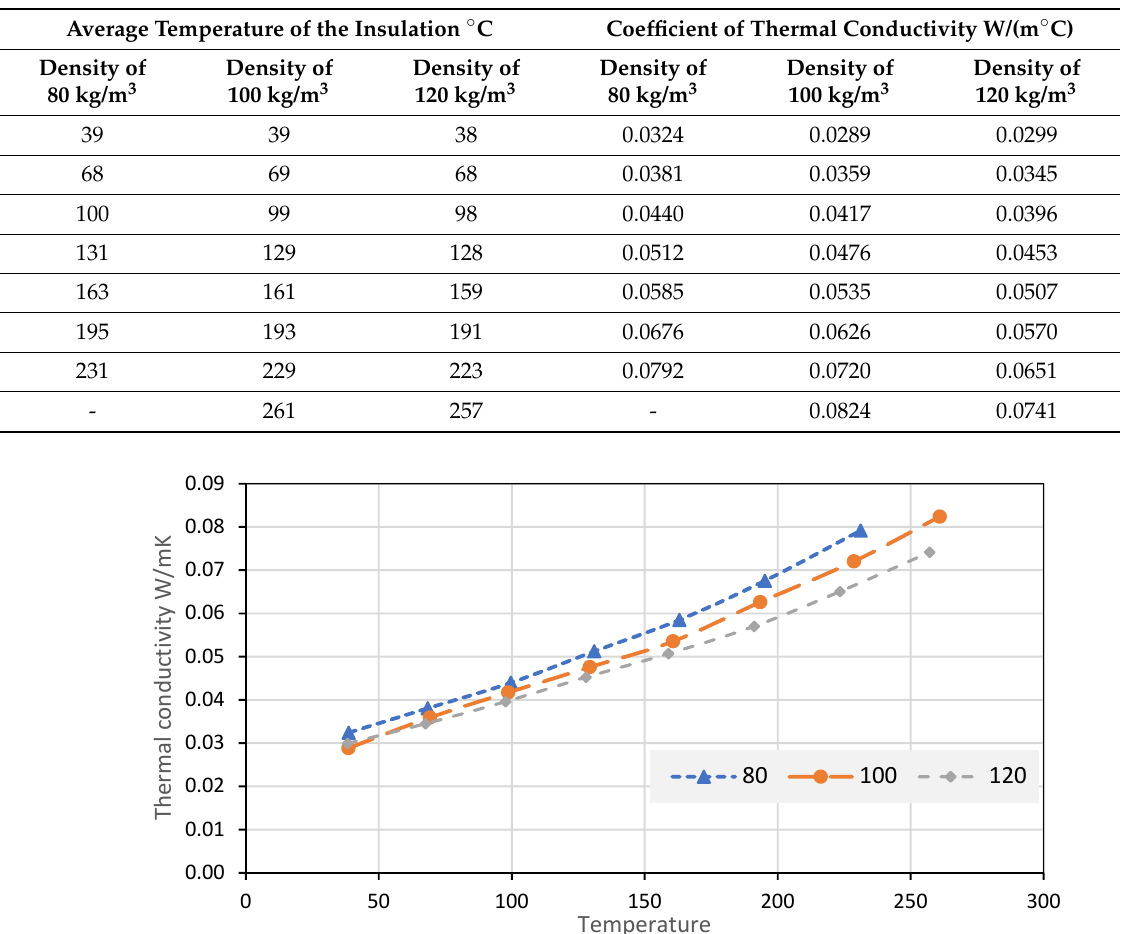
Figure 7. Dependence of the thermal conductivity coefficient (W/m°C) from the temperature (°C) for materials with densities of 80, 100, and 120 kg/m 3. Table 2. Values of the thermal conductivity coefficient for materials with densities of 80, 100, and 120 kg/m 3 for insulated surface temperatures in the range from 50 to 400 °C.